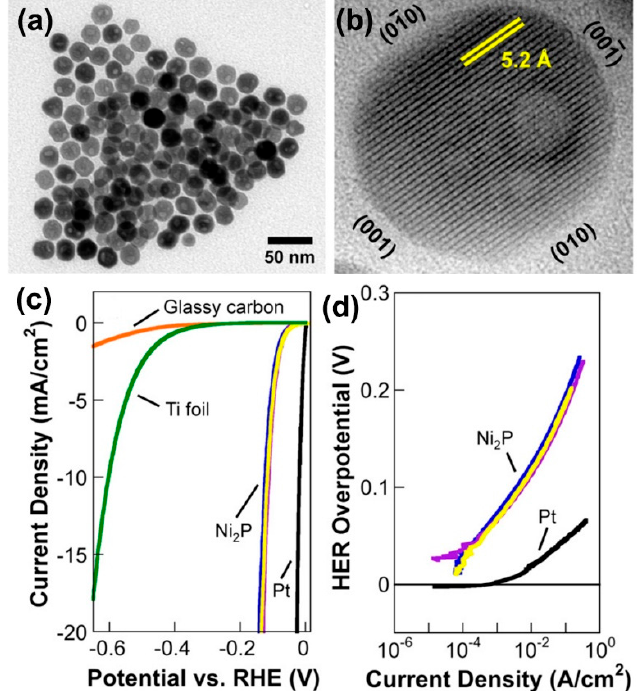
Figure 3. TEM image ( a ) and HRTEM image ( b ) of a representative Ni 2 P nanoparticle, highlighting the exposed Ni 2 P (001) facet and the 5.2 Å lattice fringes that correspond to the (010) planes. Polarization curves for Ni 2 P electrodes, glassy carbon, Ti foil, and Pt in 0.5 M H 2 SO 4 for comparison ( c ) and corresponding Tafel plots ( d ). Reproduced with permission from Reference [45], the American Chemical Society, 2015.